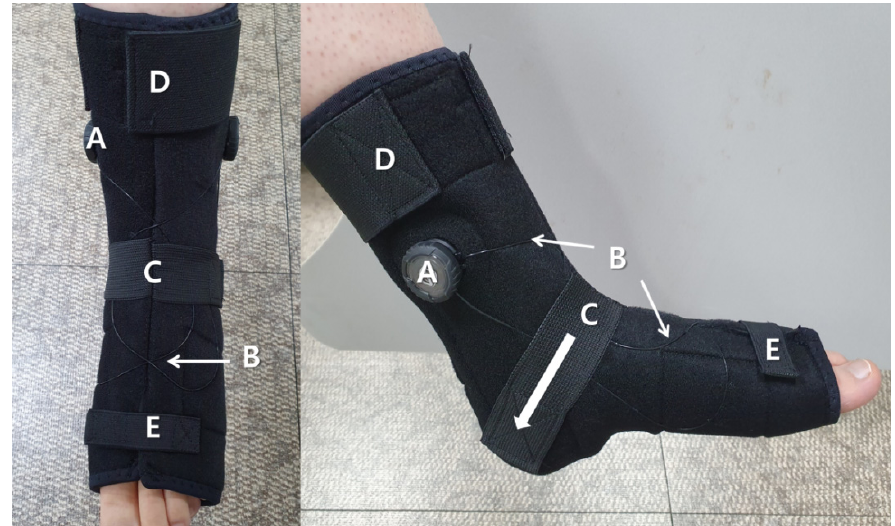
Figure 2. Lateral view of the ankle–foot orthosis using wire. A: wire adjustor; B: wire; C: talus posterior gliding Velcro; D: Velcro for ankle fixation; E: metatarsal joint stabilization strap.